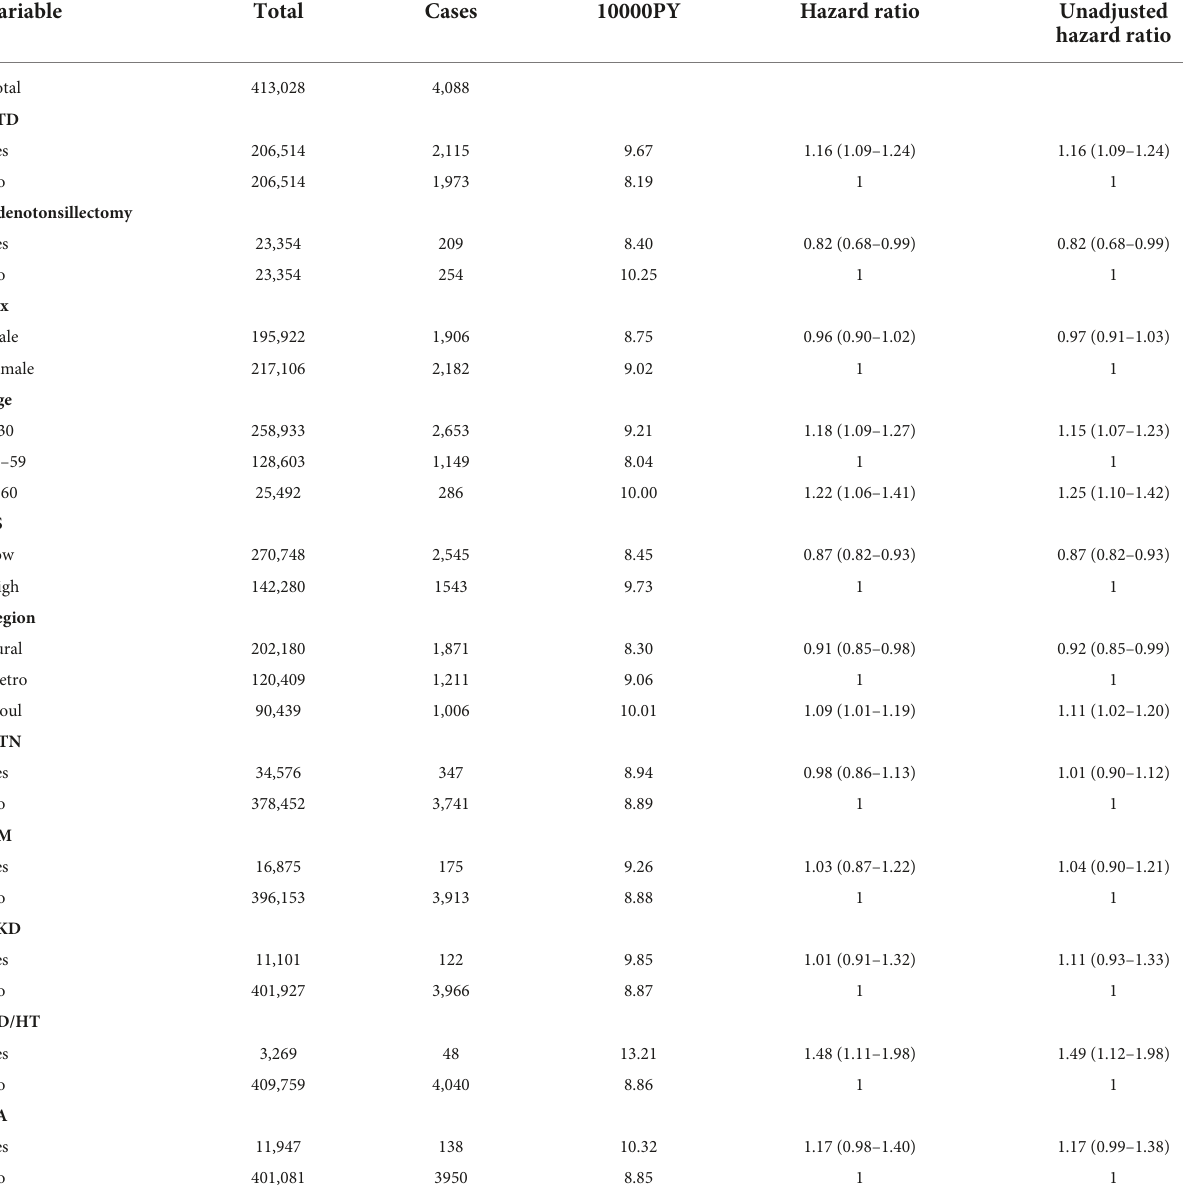
TABLE 2 Incidence per 10000 person-years and hazard ratios for vitiligo.